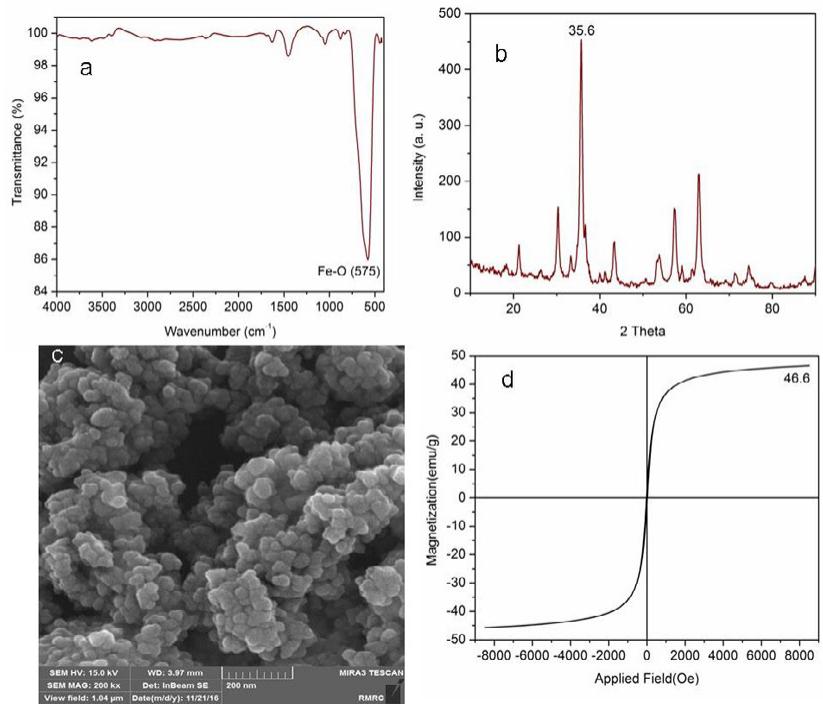
Fig. 1: FT-IR spectrum (a), XRD pattern (b), SEM image (c), and Magnetic properties (d)